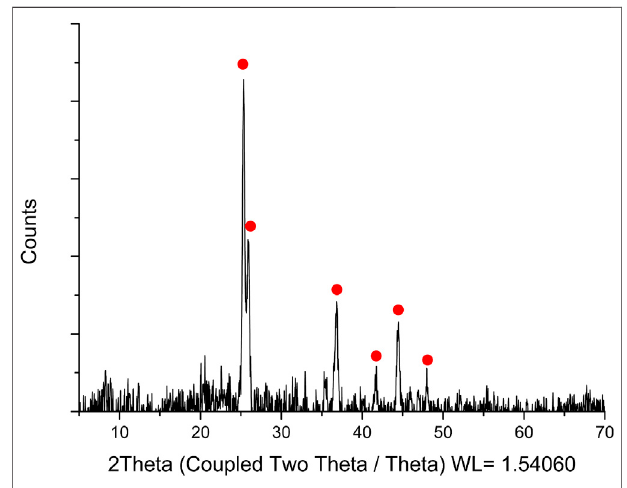
FIGURE 3 | X-ray diffraction analysis of a bulk sample of P. catenata culture incubated with Sr. Red dots indicate the presence of calcian strontianite [(Sr 0.85, Ca 0.15) (CO 3